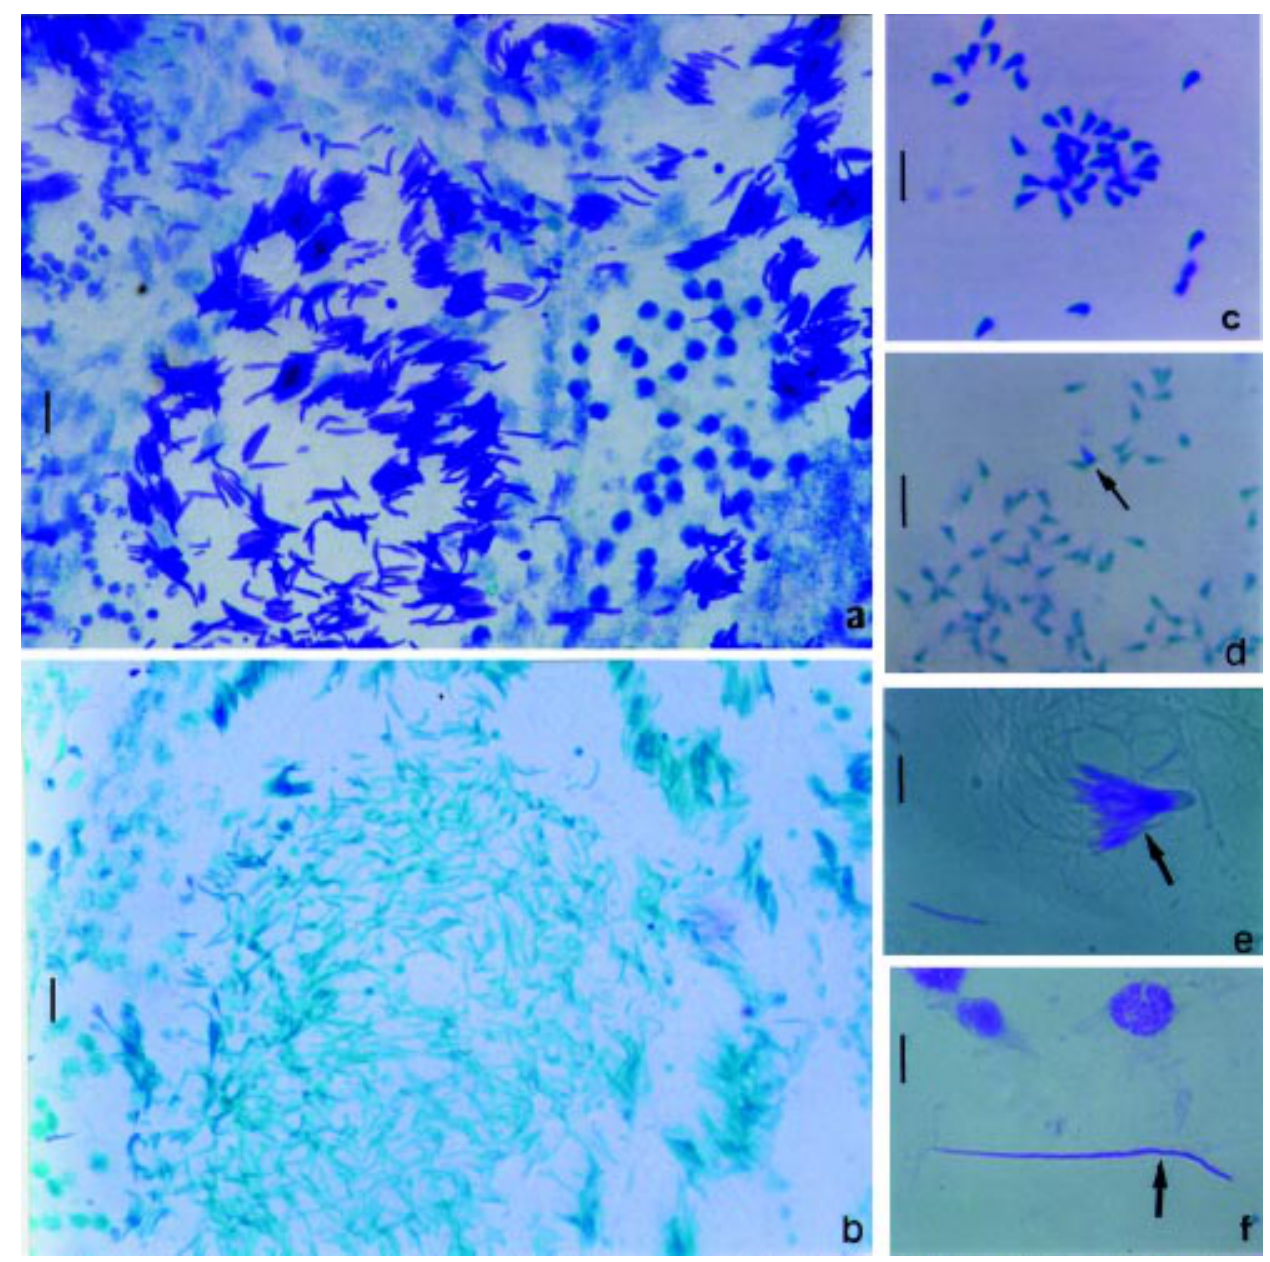
Figure 1 a-f - TB staining in the absence (a, c, e, f) or presence of Mg 2+ ions (b, 0.10 M; d, 0.12 M) in sperm cell nuclei. a,b: Rana catesbeiana ; c,d: Lytechinus variegatus ; e: Bombus atratus ; f: Eulaema nigrita. d, Metachromatically stained nucleus (arrow) of L. variegatus at the CEC. Most of the nuclei are stained green. e,f, A group of spermatozoal heads and an individual sperm cell nucleus are indicated (arrow). Bar: 10 m